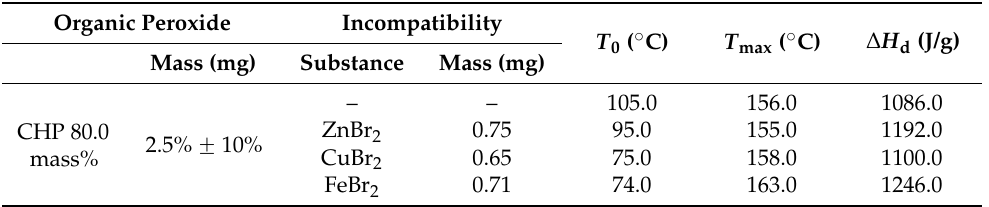
Table 2. Nonisothermal data obtained from differential scanning calorimetry (DSC) tests for 80.0 mass% cumene hydroperoxide (CHP) mixed with ZnBr 2 , CuBr 2 , and FeBr 2 at 4.0 ˝ C.